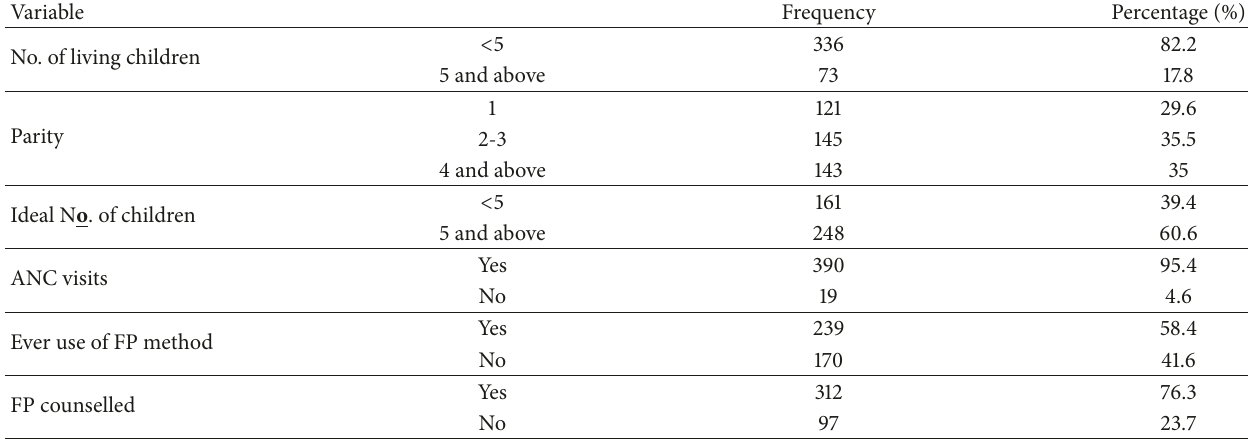
Table 2: Reproductive health characteristics of postpartum women in Tahtay Koraro Woreda, Tigray, Ethiopia, 2014. (N=409) . Variable